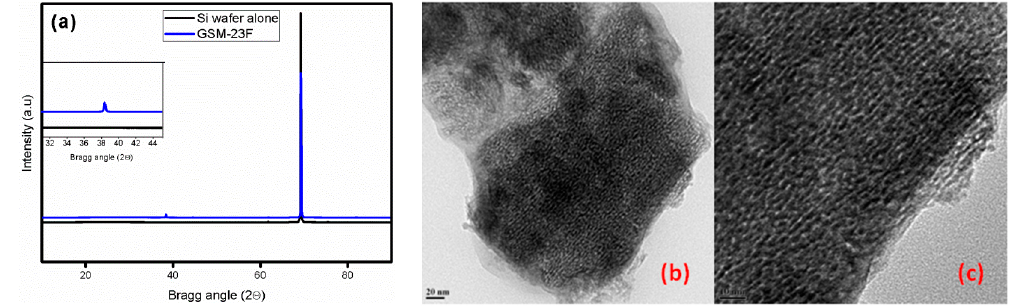
Figure 1. Wide angle XRD spectra of the bare silicon wafer and the GSM-23F film ( a ) TEM analysis of the GSM-23F thin film with different magnifications, scale bars ( b ) 20 nm and ( c ) 10 nm .